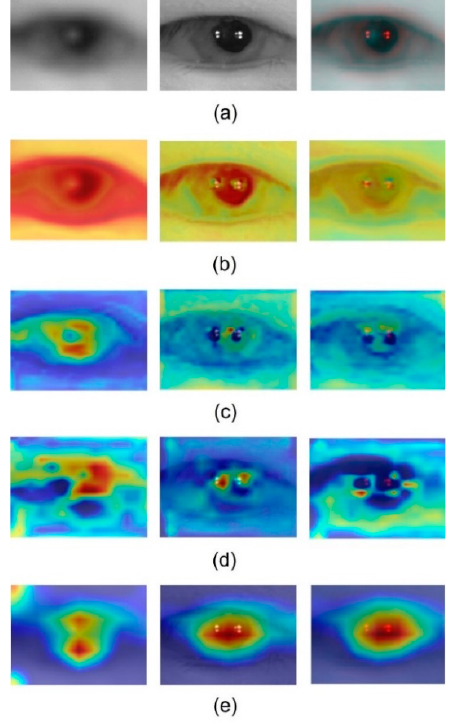
Figure 11. Grad-CAM extraction results. Each row in the figure is a low-resolution image before restoration, bilinear interpolated high-resolution image, high-resolution image after being restored by OSRCycleGAN, and when mixed images of bilinear interpolation (two channels) + OSRCycleGAN (one channel) in Tables 8–10 are used as input in the ResNet-101. ( a ) of each column is the input image. ( b ) Grad-CAM image extracted from second residual block layer, ( c – e ) are Grad-CAM image extracted from third, fourth and fifth residual block, respectively.